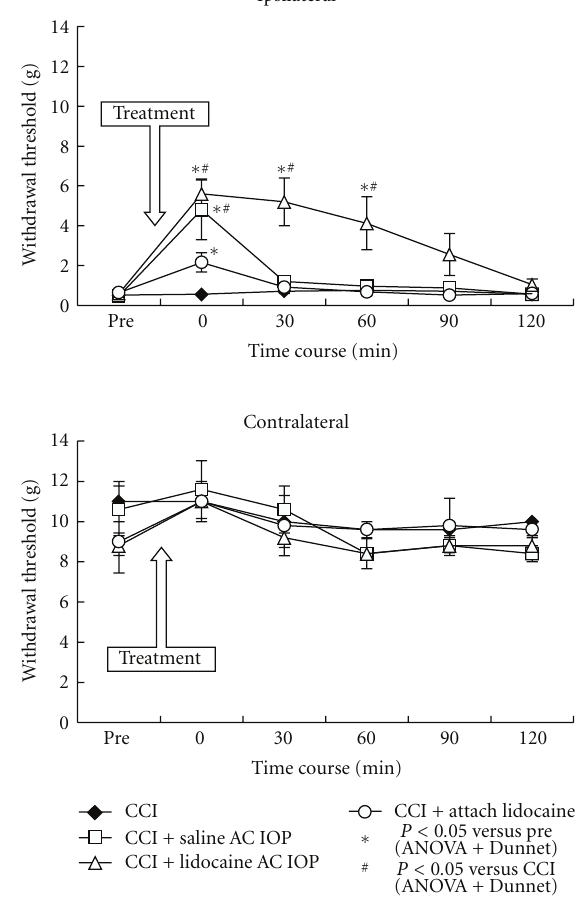
CCI + attach lidocaine P < 0 . 05 versus pre CCI + saline AC IOP (ANOVA + Dunnet) CCI + lidocaine AC IOP P < 0 . 05 versus CCI (ANOVA + Dunnet) Figure 3: After 60min treatment, mechanical withdrawal thresh- olds were measured at 0, 30, 60, 90, and 120 min. A significant increase in the withdrawal threshold was observed in the CCI + lidocaine AC IOP group until 60min after treatment. The value in the CCI + saline AC IOP group at 0min also increased significantly. The values in the CCI + attach lidocaine group at 0min increased significantly compared with those prior to AC IOP; however no significant di ff erence was observed compared with the values in the CCI group. All the changes were observed on the ipsilateral side. ∗ ,# P < 0 . 05, n = 5. that in the sham group to demonstrate that the change in the withdrawal threshold was not caused by inflammation because of the